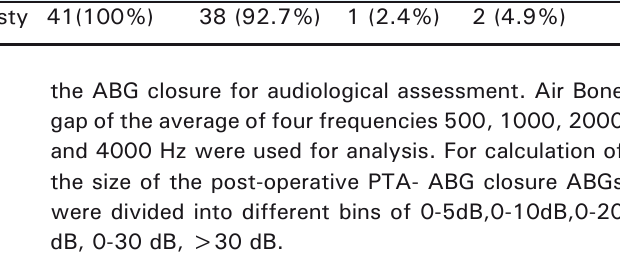
table 1. total distribution of patients (n=41) Groups